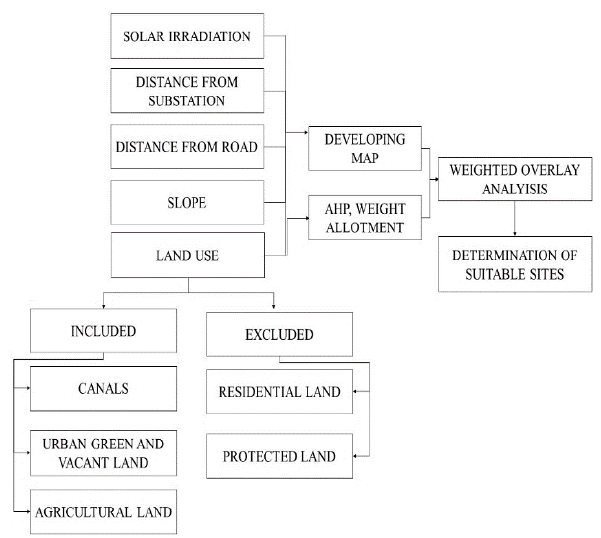
Figure 3 . Description of method